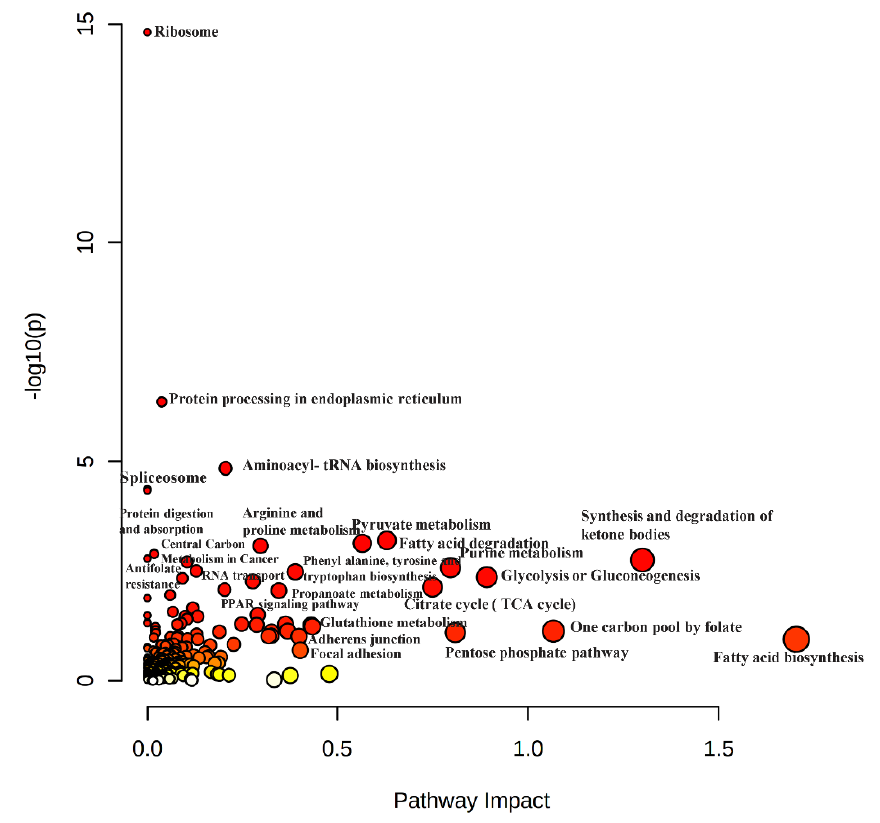
Figure 7. Visualization of joint pathway enrichment analyses. Graph that resulted from the joint pathway enrichment analysis using MetaboAnalyst of the proteins and metabolites that altered significantly ( p value < 0.05) in resistant Hep3B cells vs. parental Hep3Bcells. Nodes are colored according to p value. Significant pathways are colored red, while non-significant pathways are colored yellow to white. Nodes are sized according to the number of associated members proteins and/or metabolites.